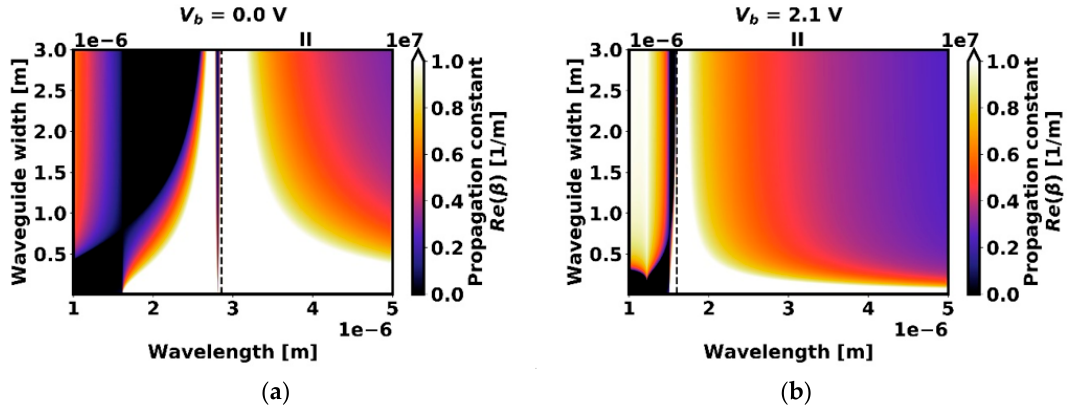
Figure 5. Map of propagation constant values for TM1 in configuration A at various bias voltages: ( a ) 0 V and ( b ) 2.1 V. Type II HMM dispersion region is indicated.